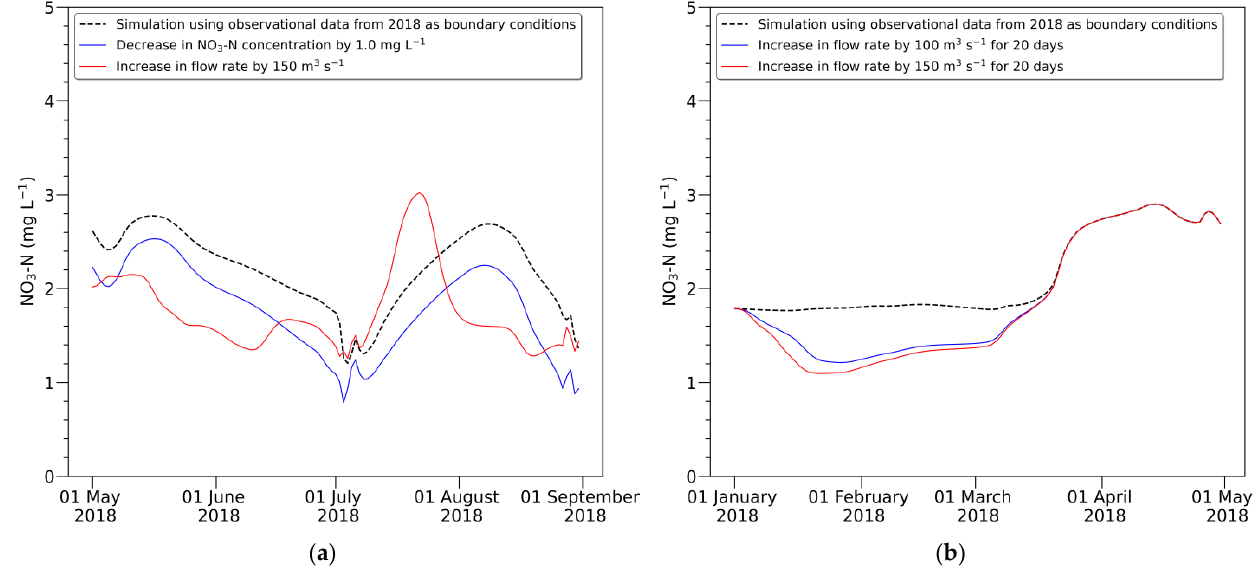
Figure 13. Changes in the NO 3 -N concentration in cross section 416 caused by variations in the NO 3 -N concentration at the upstream boundary. The black graphs show results simulated using the observational data from 2018 as boundary conditions. ( a ) Changes in the NO 3 -N concentration by a decrease or increase in the NO 3 -N concentration (Scenarios 49–52); ( b ) changes in the NO 3 -N concentration by a constant concentration of NO 3 -N (Scenarios 53–55).